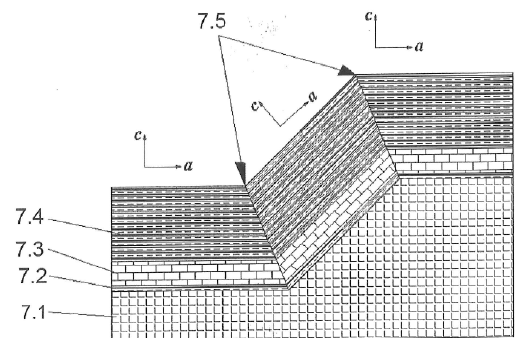
Figure 3. Schematic representation of a step-edge high-T c Josephson junction developed at FZJ [28].